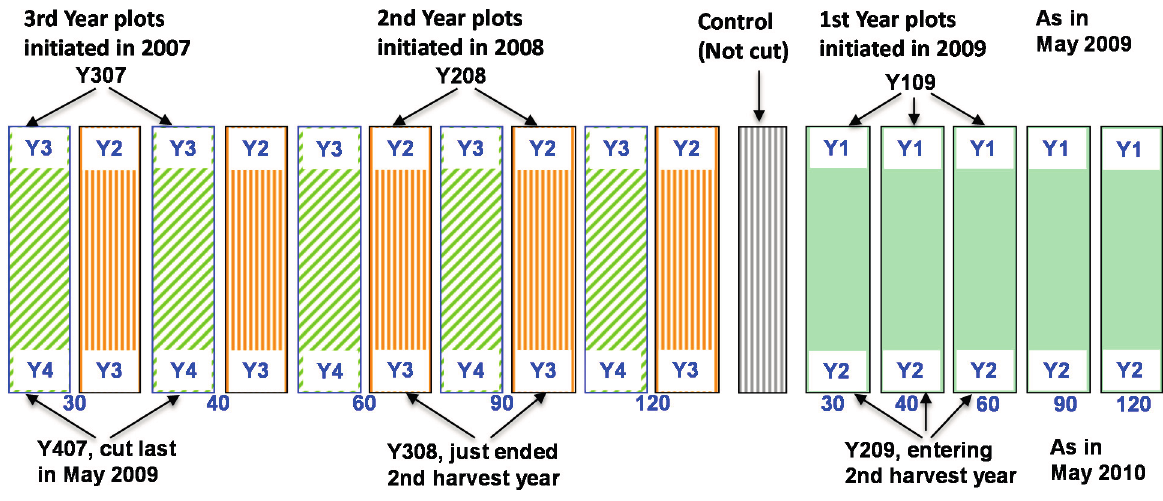
Figure 1. Schematic field layout of 7.5 m-long and 1 m-wide plots, in one replication, assigned to 30-, 40-, 60-, 90- and 120-d harvest intervals and sequentially introduced into the respective harvest regimes between May of 2007 and 2009. As in May 2009, plots labeled Y1, Y2, and Y3, were entering their first, second and third year, while in May 2010, the same plots were in their second, third, and fourth year in the trial,